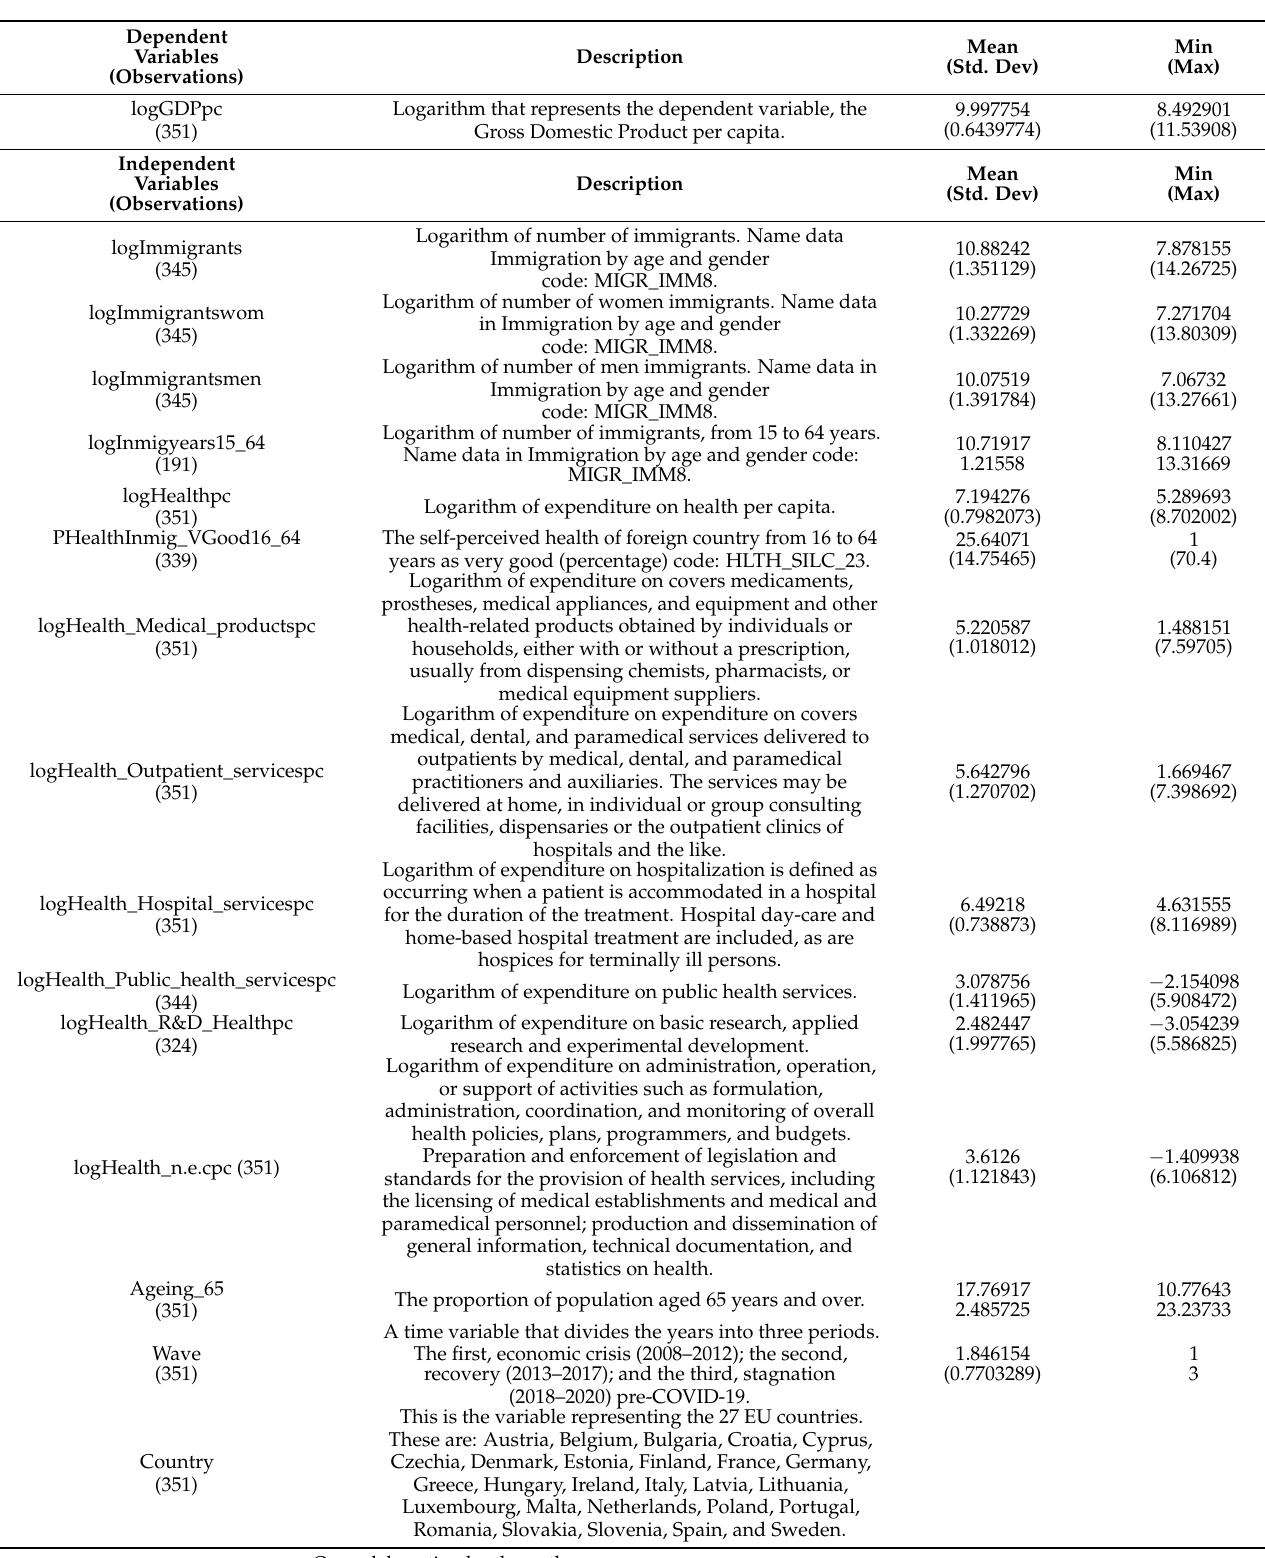
Table 1. Description of